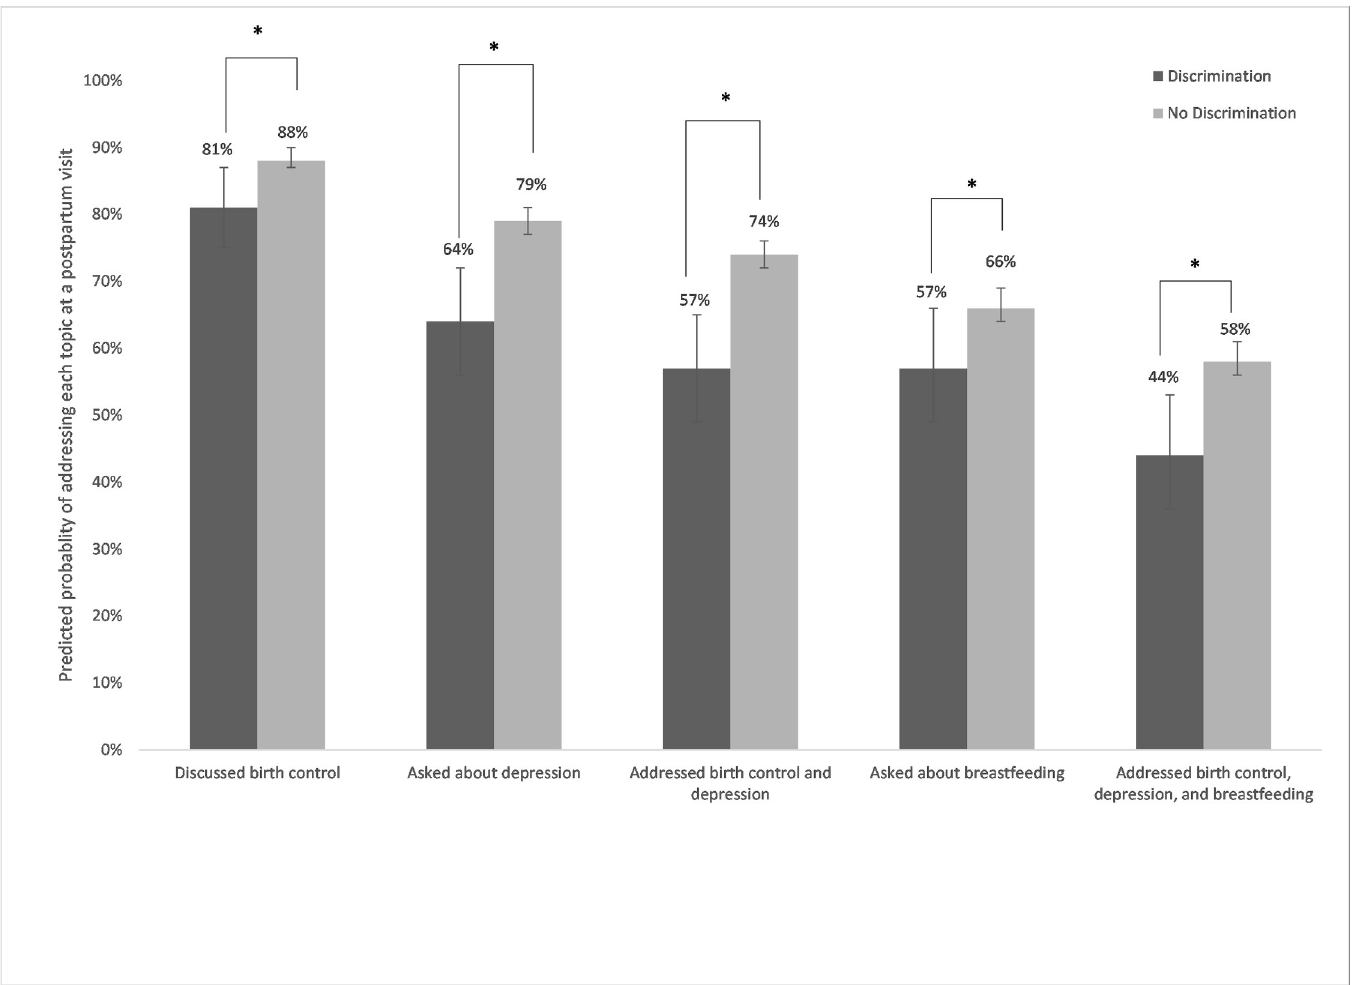
Fig 2. Predicted probabilities of topics addressed at postpartum visit by perceived discrimination. Note : � Indicates difference between the estimates is statistically significant with p < 0.05. 95% confidence intervals are shown with vertical bars. Predicted probabilities are estimated from logistic regression models adjusted for race/ ethnicity, insurance type, education, language, age, birth mode, gestational age, parity, prenatal care provider type, and pre-pregnancy obesity. Models including breastfeeding outcomes are limited to women who reported breastfeeding at 1 week postpartum. Results are weighted to be representative of singleton hospital births in